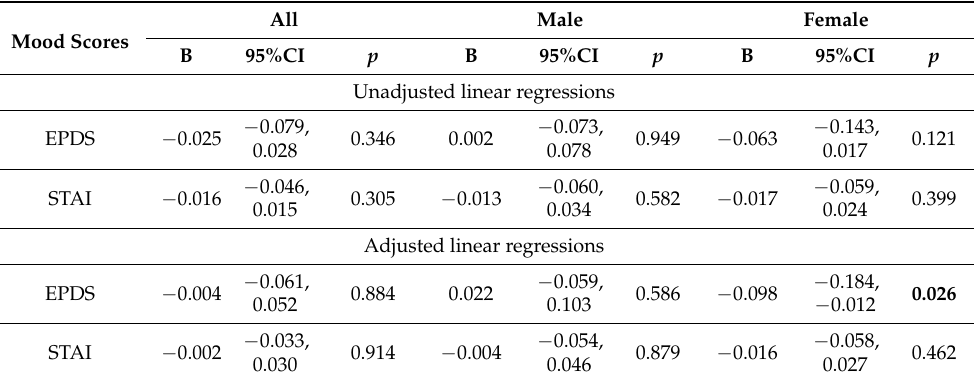
Table 3. Analysis of the association between mean telomere length and maternal mood scores using unadjusted and adjusted multiple linear regression models. Adjusting for maternal age, gestational age, parity, BMI, smoking during pregnancy, alcohol during pregnancy, WIMD score and EPDS/STAI. A p -value < 0.05 is considered statistically